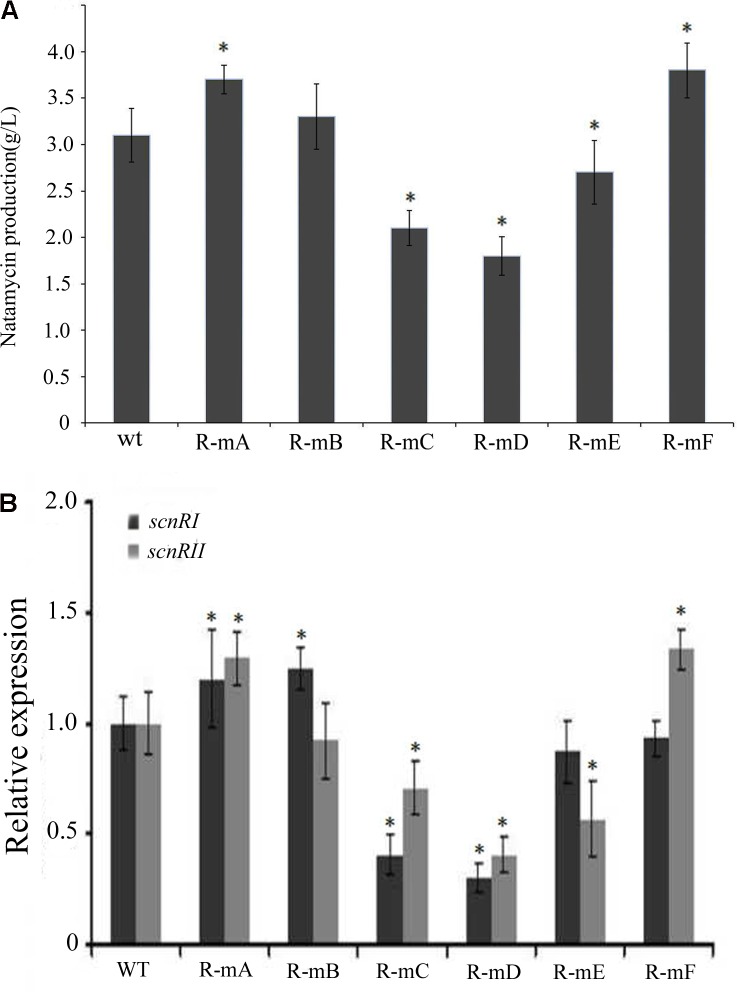
(A) The effect of mutated AdpAch-binding sites on the natamycin production in vivo. The strains were grown in YEME medium for 96 h. Vertical error bars correspond to the standard error of the mean of four replicated cultures. (B) Real-time RT-PCR analysis of the scnRI and scnRII transcript in the wt strain and mutated AdpAch-binding sites strain. The expression level of scnRI and scnRII is presented relative to the wt sample from 24 h, which was arbitrarily assigned a value of 1. The transcription of hrdB was assayed as an internal control. Error bars were calculated by measuring the standard deviation among three replicates of each sample. ∗ Indicates significant differences between AdpAch-binding site mutants and wt (P < 0.05).